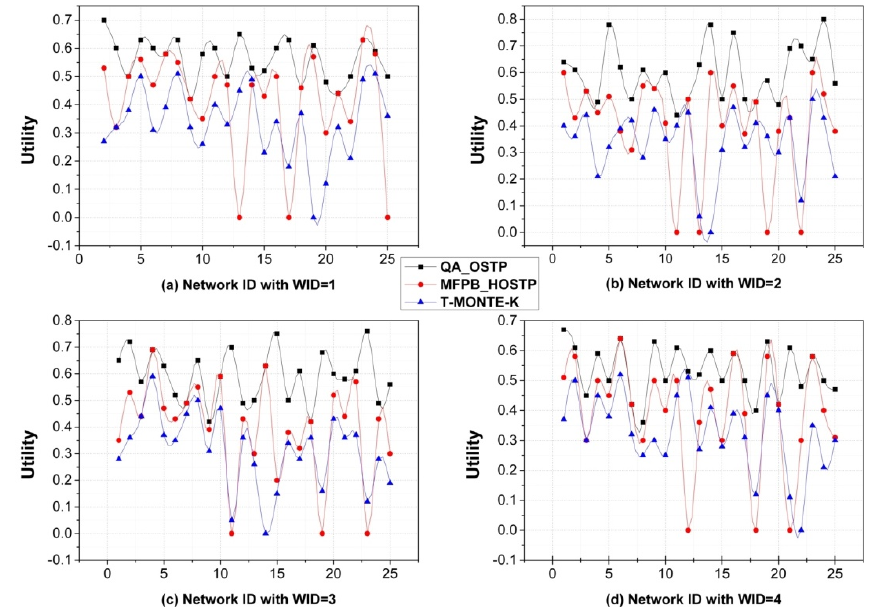
Figure 3. Comparison of path utilities of networks.